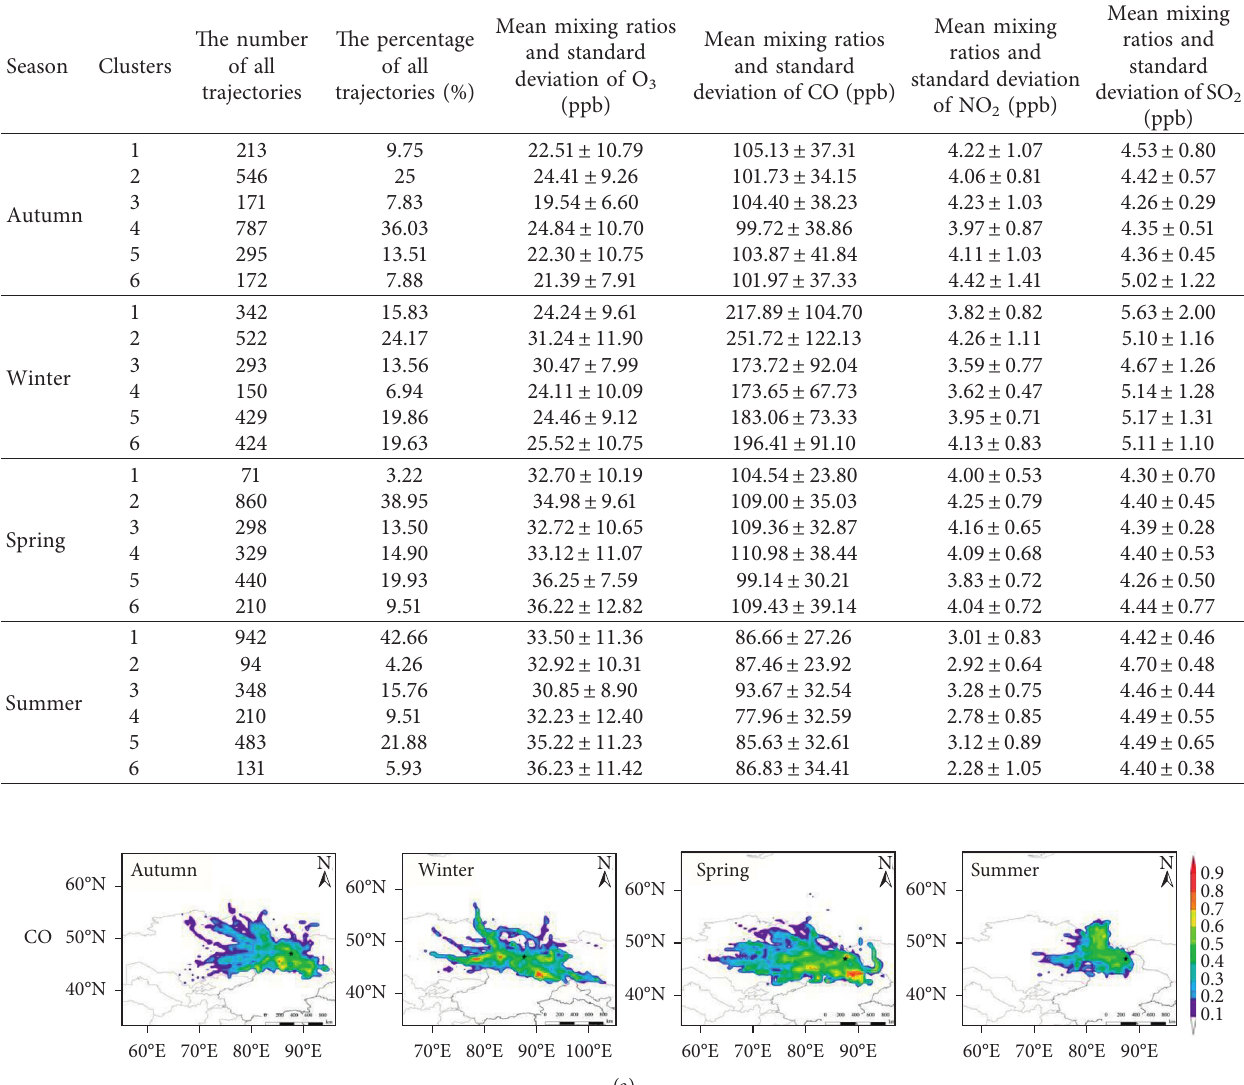
Table 2: Seasonal statistical analysis results of various trajectories in